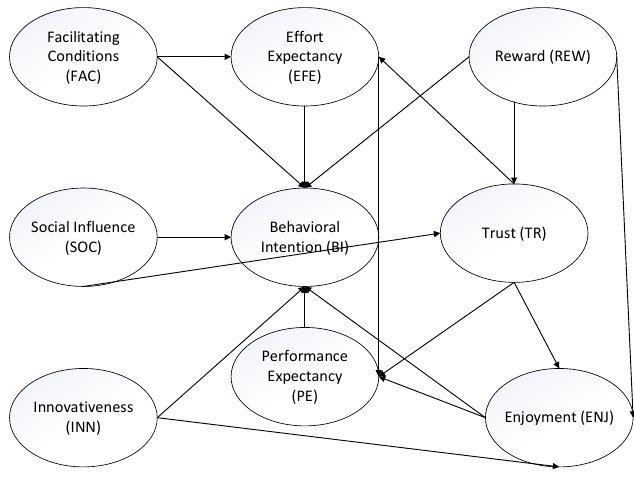
Figure 1. Conceptual Framework.